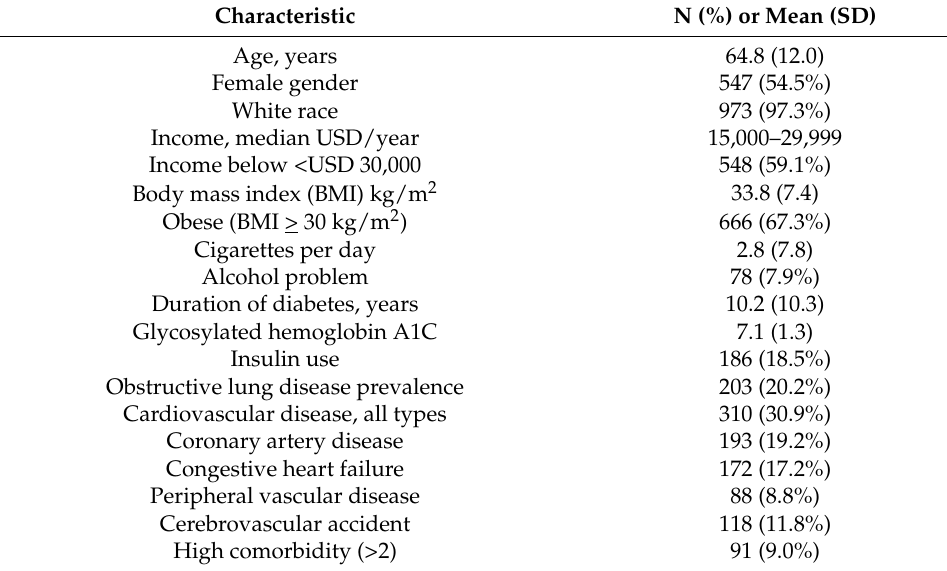
Table 1. Baseline characteristics of 1003 adults with